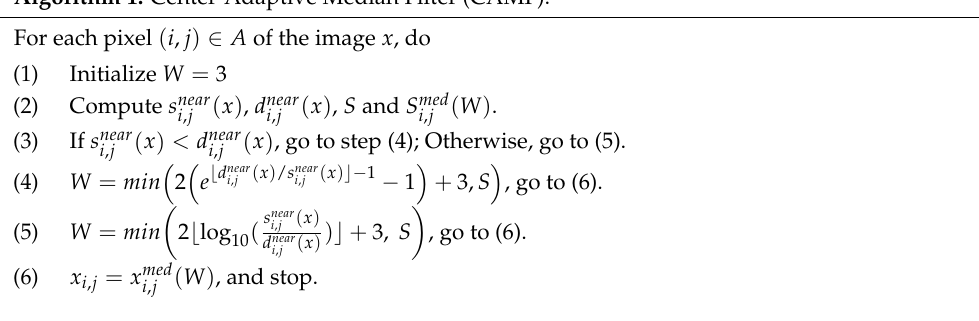
Algorithm 1. Center-Adaptive Median Filter